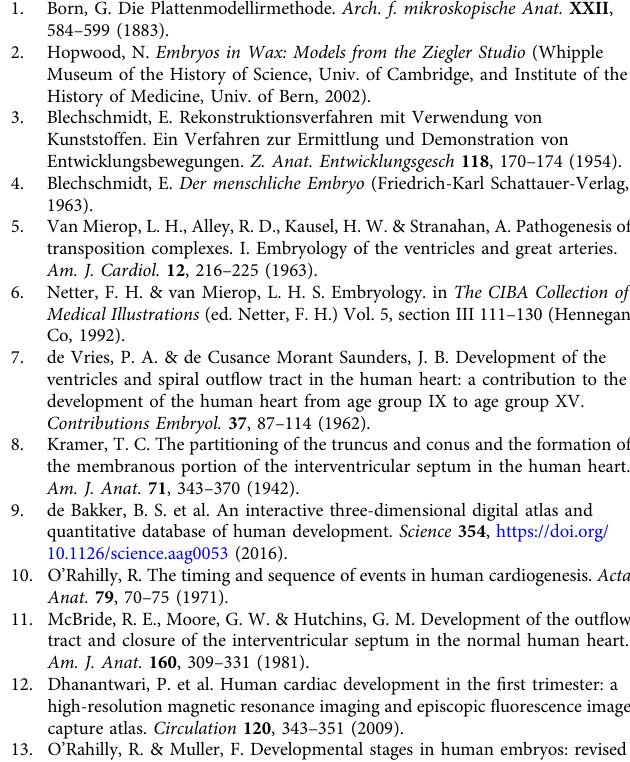
Table 3. An overview of the work fl ow from the raw 3D reconstruction in Amira via the polished 3D con fi guration in Cinema 4D to the interactive 3D-PDF is shown in Supplemental Fig. 19.